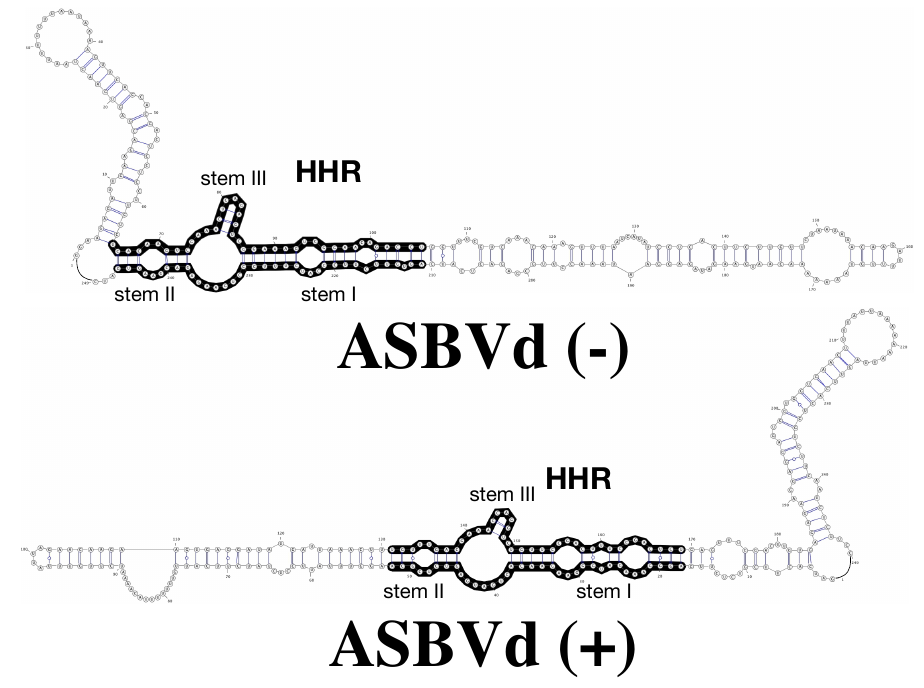
Figure 1. RNA 2D structures of Avocado Sun Blotch Viroid (ABSVd) ( − ) and ASBVd (+) (top and bottom, respectively). The full length genome of ASBVd can fold into 2D structures that preserve the hammerhead ribozyme (HHR) motif (regions in black) in both the ( − ) and (+) strands; the HHR motif of ASBVd ( − ) is more stable, with 3 base-pairs in stem III but only two base-pairs in ASBVd